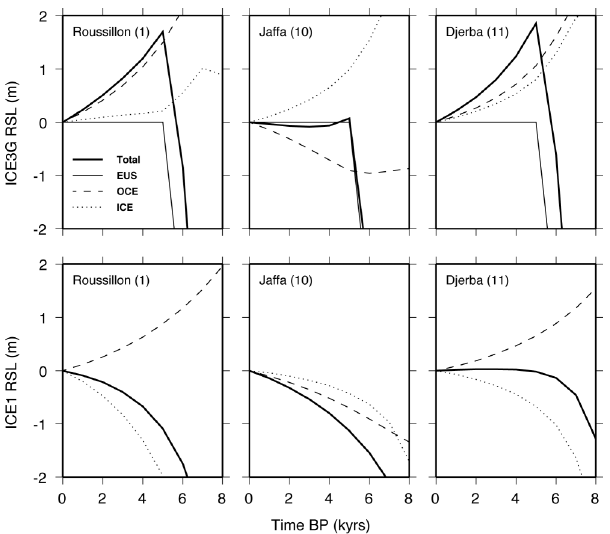
Fig. 5. Ice- and ocean-load induced components of RSL for the sites of Roussillon, Jaffa, and Djerba (the sites location is shown in fig. 3a), using ICE3G ( top ) and ICE1 ( bottom ). Since in ICE1 the end of deglaciation oc- curs 8 kyrs BP (see fig. 1a-f), its eustatic component vanishes in this time window (not shown in figure).